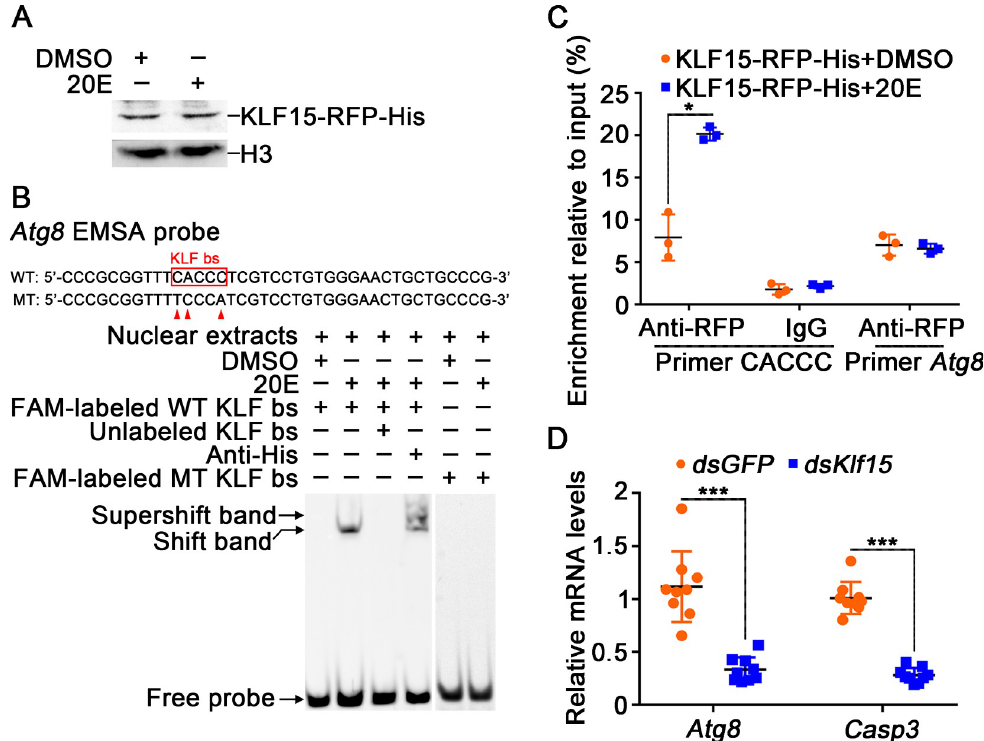
Fig 5. KLF15 promoted autophagy through upregulating Atg8 . A. Nuclear proteins from KLF15-RFP-His overexpressed cells were extracted for EMSA. B. KLF bs on the Atg8 promoter bound to KLF15 detected by EMSA assay. WT and MT represent KLF bs probe and KLF bs mutant probe, respectively. C. ChIP assay showing 20E promoted Atg8 expression via KLF15 binding to KLF bs. Primer CACCC targeting KLF bs. Primer Atg8 targeting Atg8 ORF. D. Changes in the expression levels of Atg8 and Casp3 after Klf15